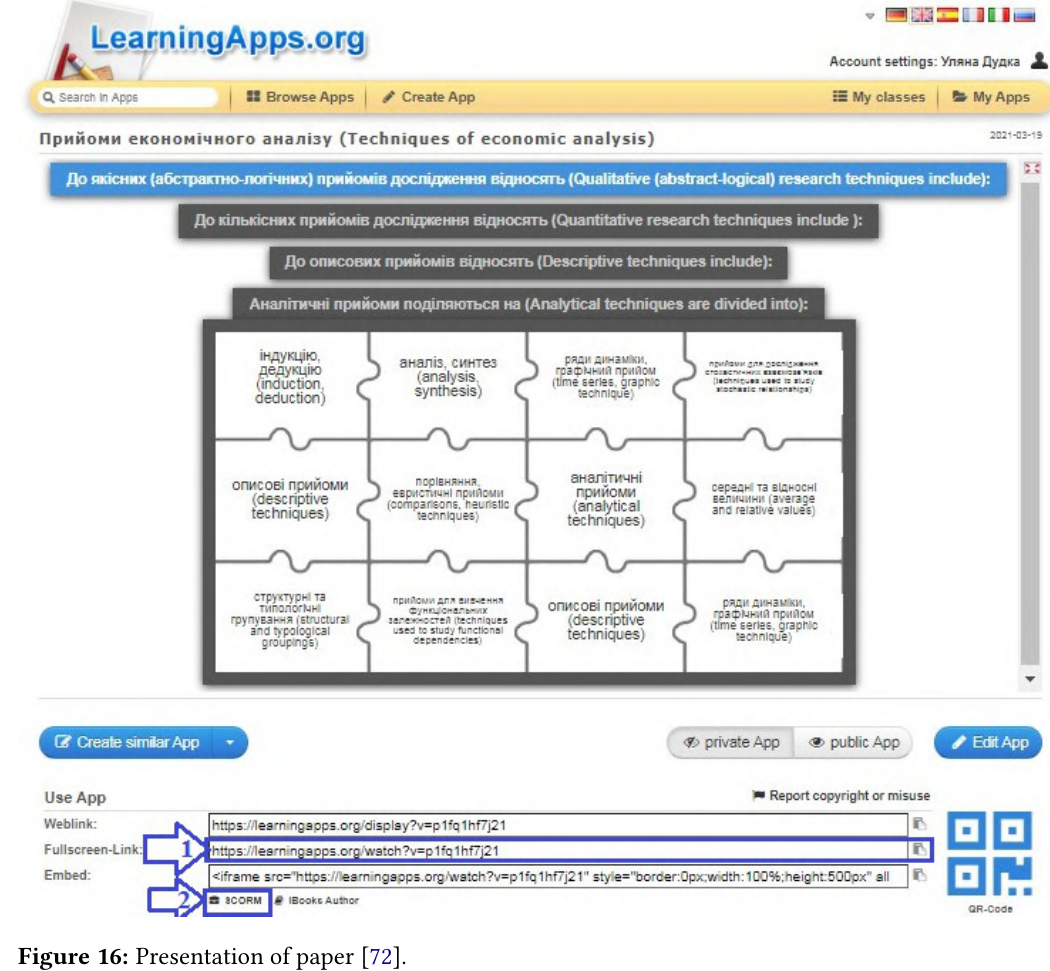
Figure 16: Presentation of paper